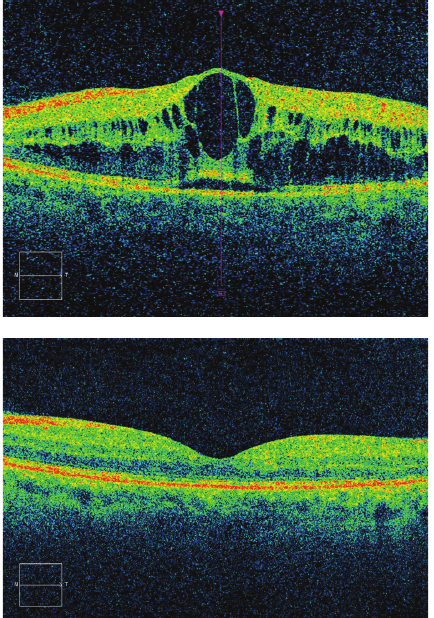
Figure 2: OCT scans: before and one month after intravitreal Ozurdex 0.7 mg injection.